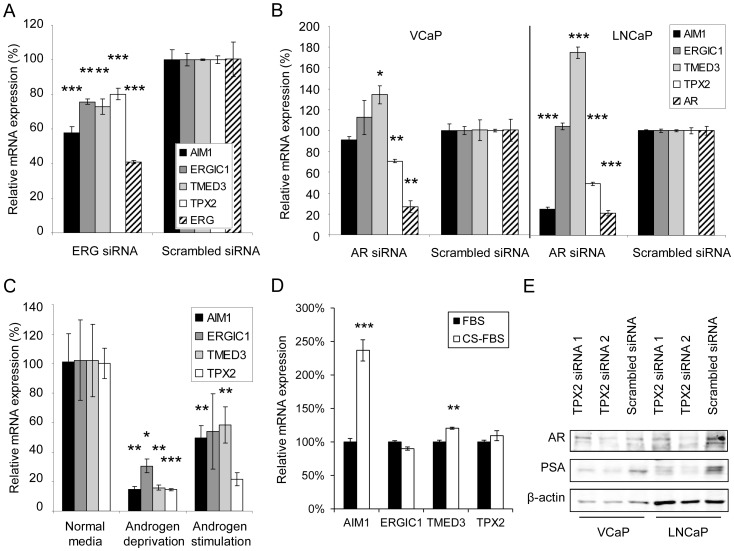

AIM1, ERGIC1, TMED3 and TPX2 expression interrelates with ERG and AR oncogene expression in vitro.
A. The effect of 48 h ERG silencing on the expression of the target genes in VCaP cells. B. The effect of 48 h AR silencing on the expression of the target genes in VCaP and LNCaP cells. C. The effect of 24 h androgen deprivation and sequential 24 h androgen stimulation (10 nM R1881) on the expression the target genes in LNCaP cells. D. The level of target mRNA expression in LNCaP cells cultured in normal media (FBS) and in chargoal-stripped (CS-FBS) androgen ablated media. E. The effect of 72 h TPX2 silencing on the protein expression of AR and PSA. β-actin has been used as a loading control. The statistical significance of the results in comparison to control experiment have been indicated.